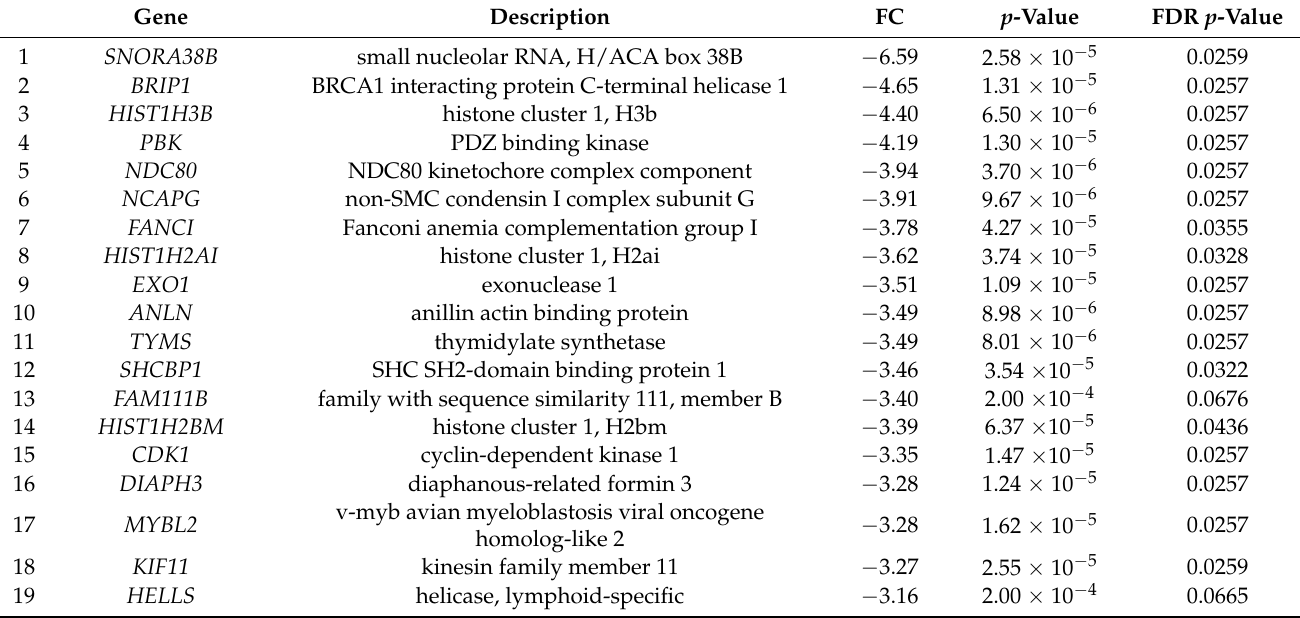
Figure 7. Transcriptome summary data for the effects of GNE-140 vs. controls in MDA-MB-231 cells. Table 1. Transcriptome shift in GNE-140 treated cells vs. controls.